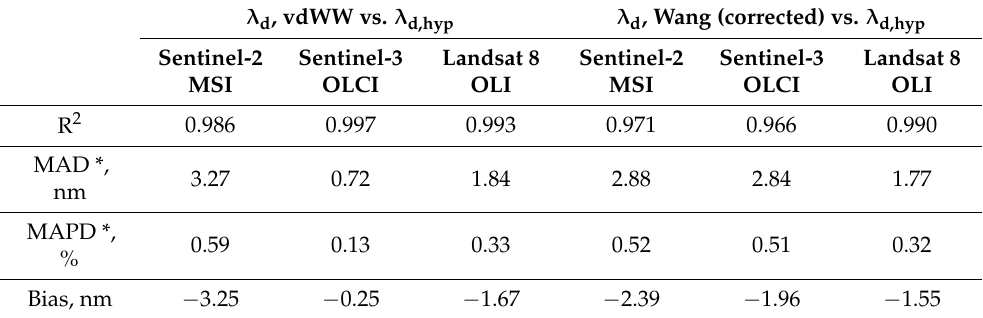
Table 3. Coefficients for correction polynomials for the Wang method.